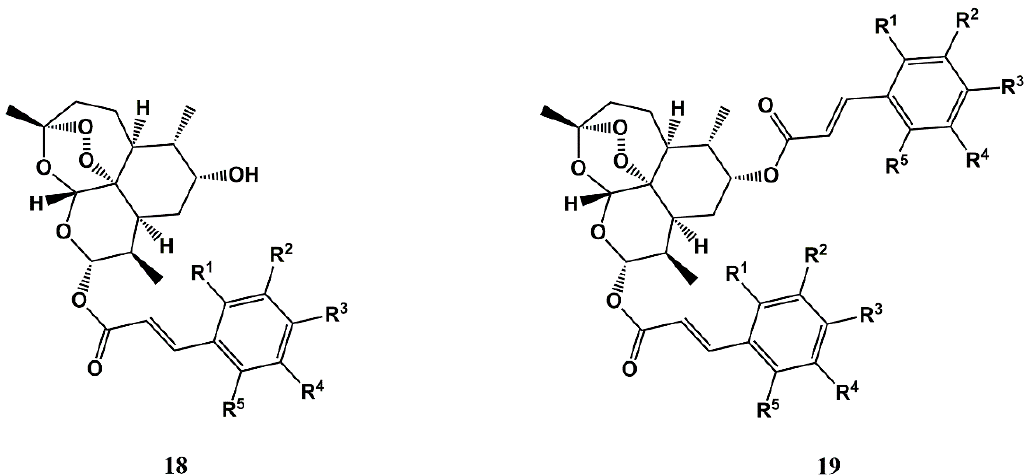
Figure 8. Antiproliferative dihydroartemisinin-CA conjugates developed by Xu et al. [78].